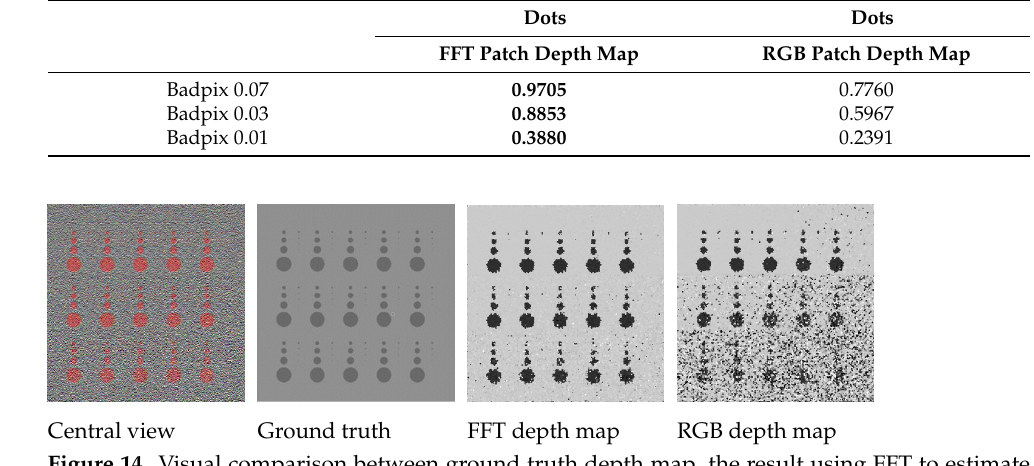
Figure 14. Visual comparison between ground truth depth map, the result using FFT to estimate depth map (proposed algorithm) and depth map estimated using RGB patches.